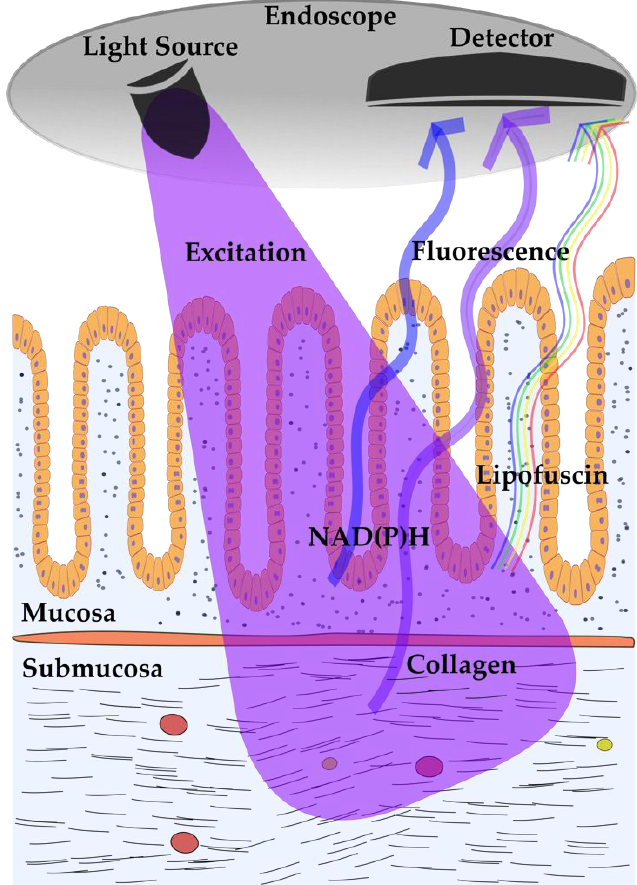
Figure 1. Schematic endoscopic autofluorescence imaging (AFI) of normal colonic tissue. In AFI mode, blue light excitation is used to excite local mucosal fluorophores, e.g., NAD(P)H or lipofuscin, and submucosal fluorophores like collagen. The endoscope is equipped with a light source and a detector to collect the emitted fluorescence light.